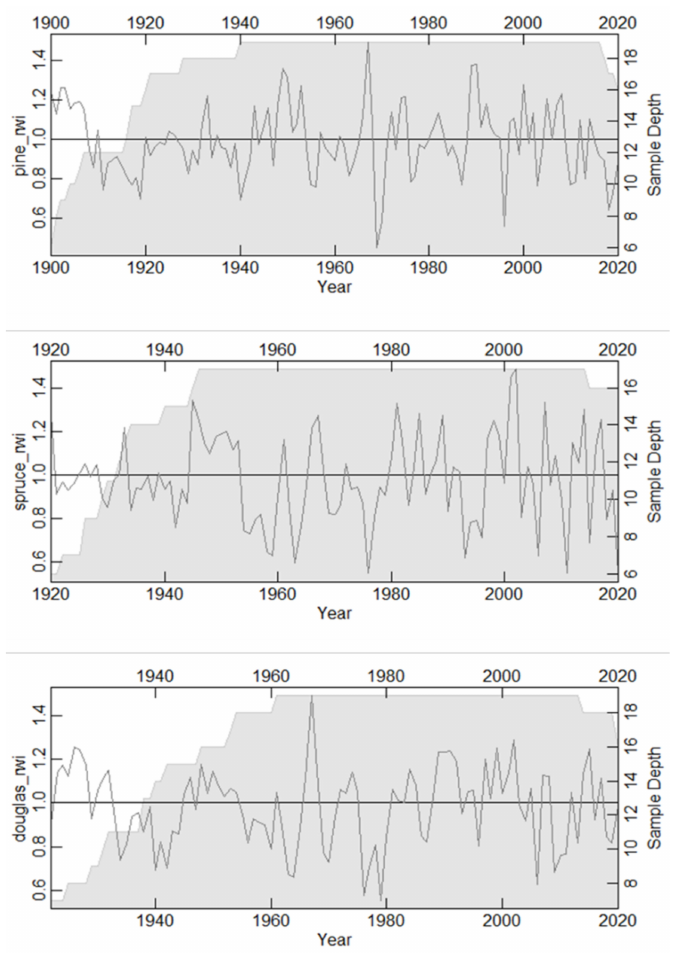
Figure 5. Ring width chronology of ( a ) Scots pine ( Pinus sylvestris ), ( b ) Norway spruce ( Picea abies ), and ( c ) Douglas fir ( Pseudotsuga menziesii ), Scharbeutz (northern Germany). Gray shaded area indicates sample depth with the scale on the right